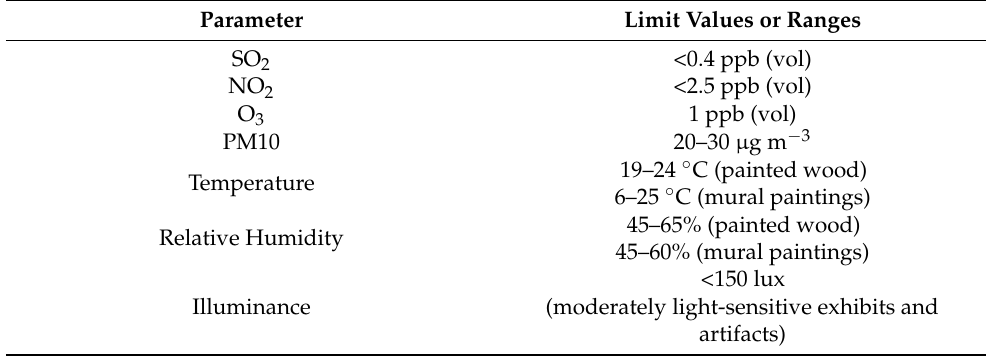
Table 1. The recommended microclimatic conditions in museum environments according to the D.M. 10 May